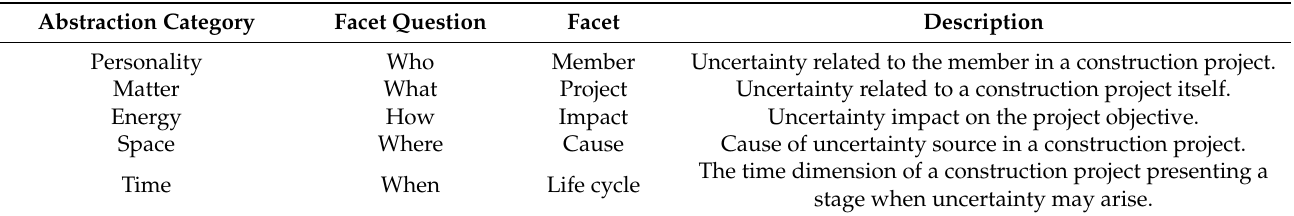
Table 1. Fundamental facets for the uncertainty sources in a construction project. Abstraction Category Facet Question Facet Description Personality Who Member Uncertainty related to the member in a construction project. Matter What Project Uncertainty related to a construction project itself.